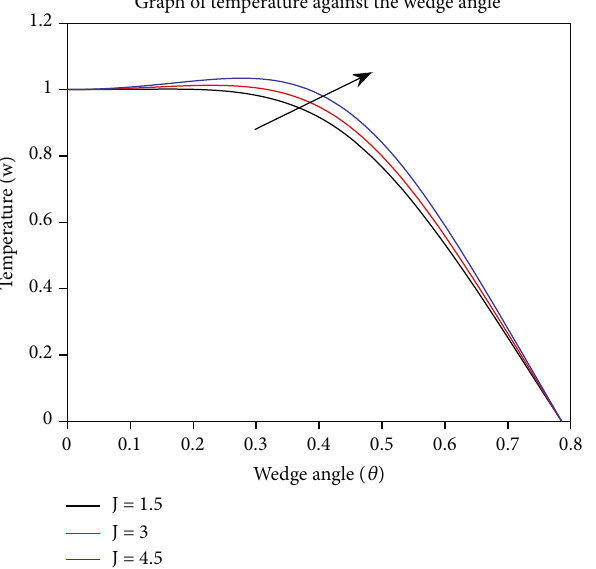
Figure 14: E ff ect of varying the unsteadiness parameter on